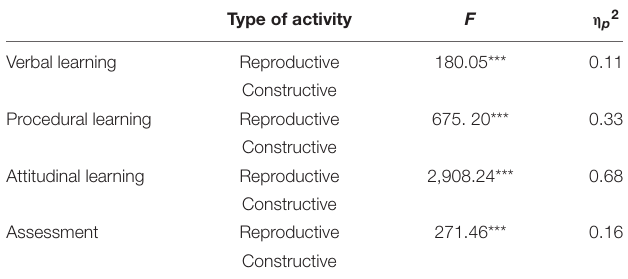
TABLE 6 | Differences between reproductive and constructive activities in the dimensions.